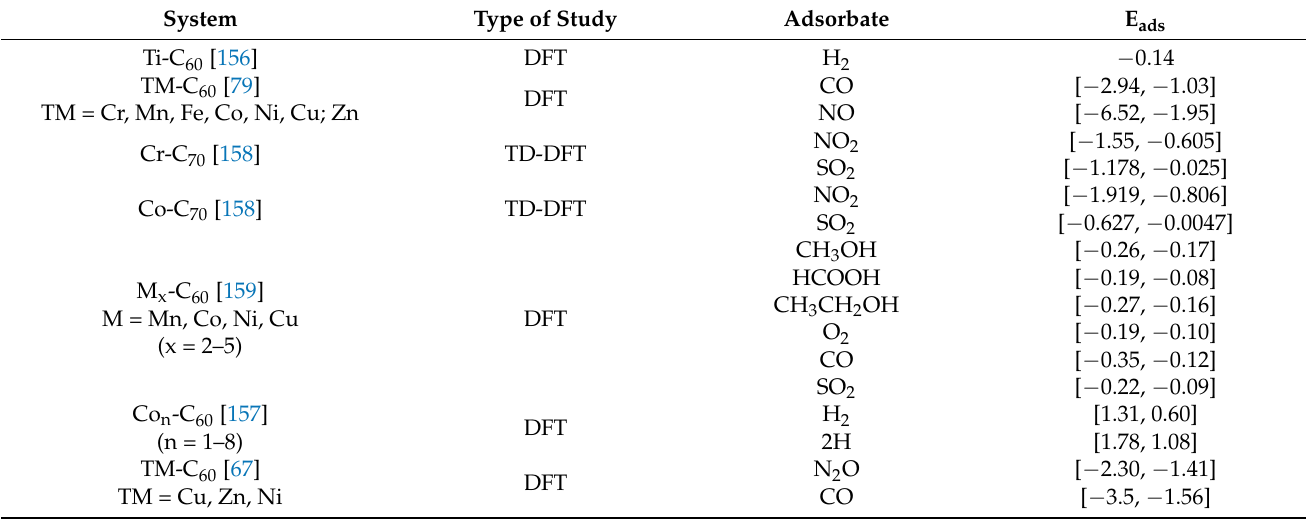
Table 9. Summary of adsorption energies E ads (in eV) for different TM-doped fullerene systems and adsorbates. The type of study is also